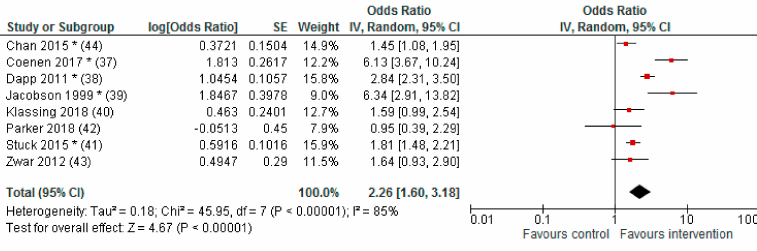
Figure 2. Forest plot (meta-analysis) of e ff ects on vaccination rates.